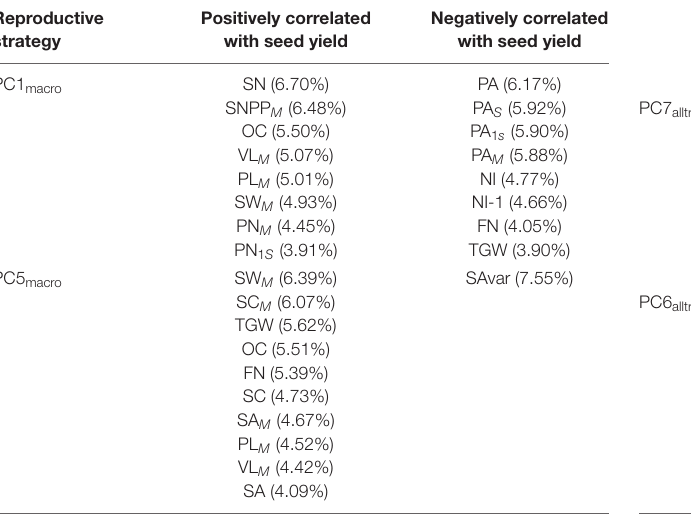
TABLE 5 | Winter OSR and Spring OSR reproductive strategies for macrotraits.